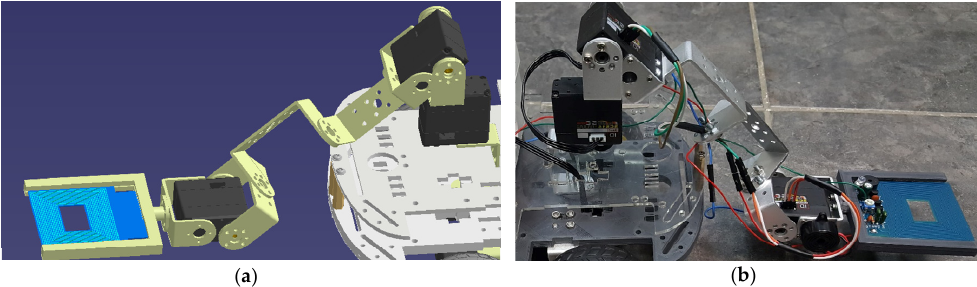
Figure 6. Robotic arm in laboratory-stage development: ( a ) CAD version; ( b ) practical test version.